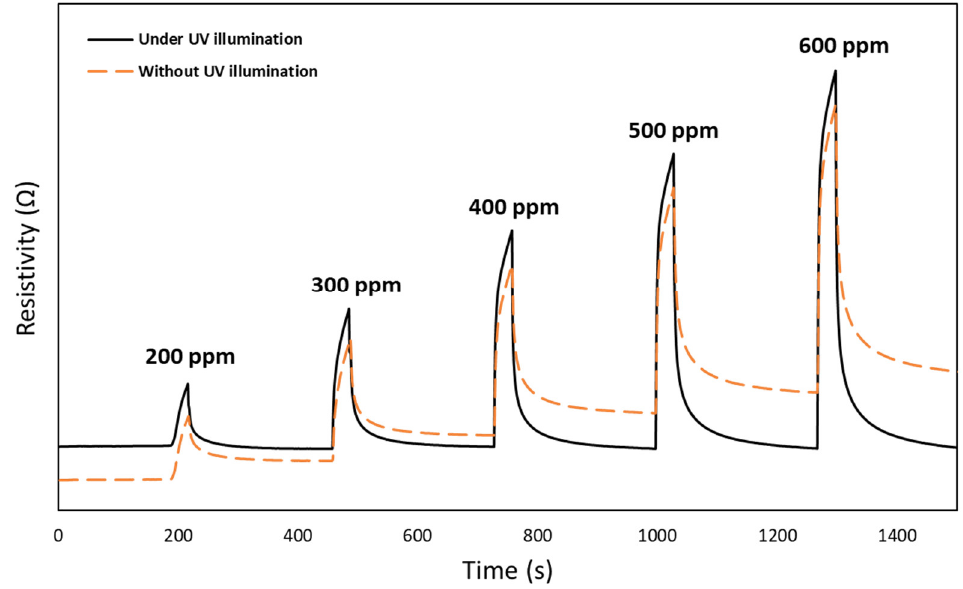
Figure 8. Dynamic response of CeO 2 -Pd-PDA/rGO sensor at 100 °C and 0% RH as a function of H 2 concentration, without and with UV illumination.